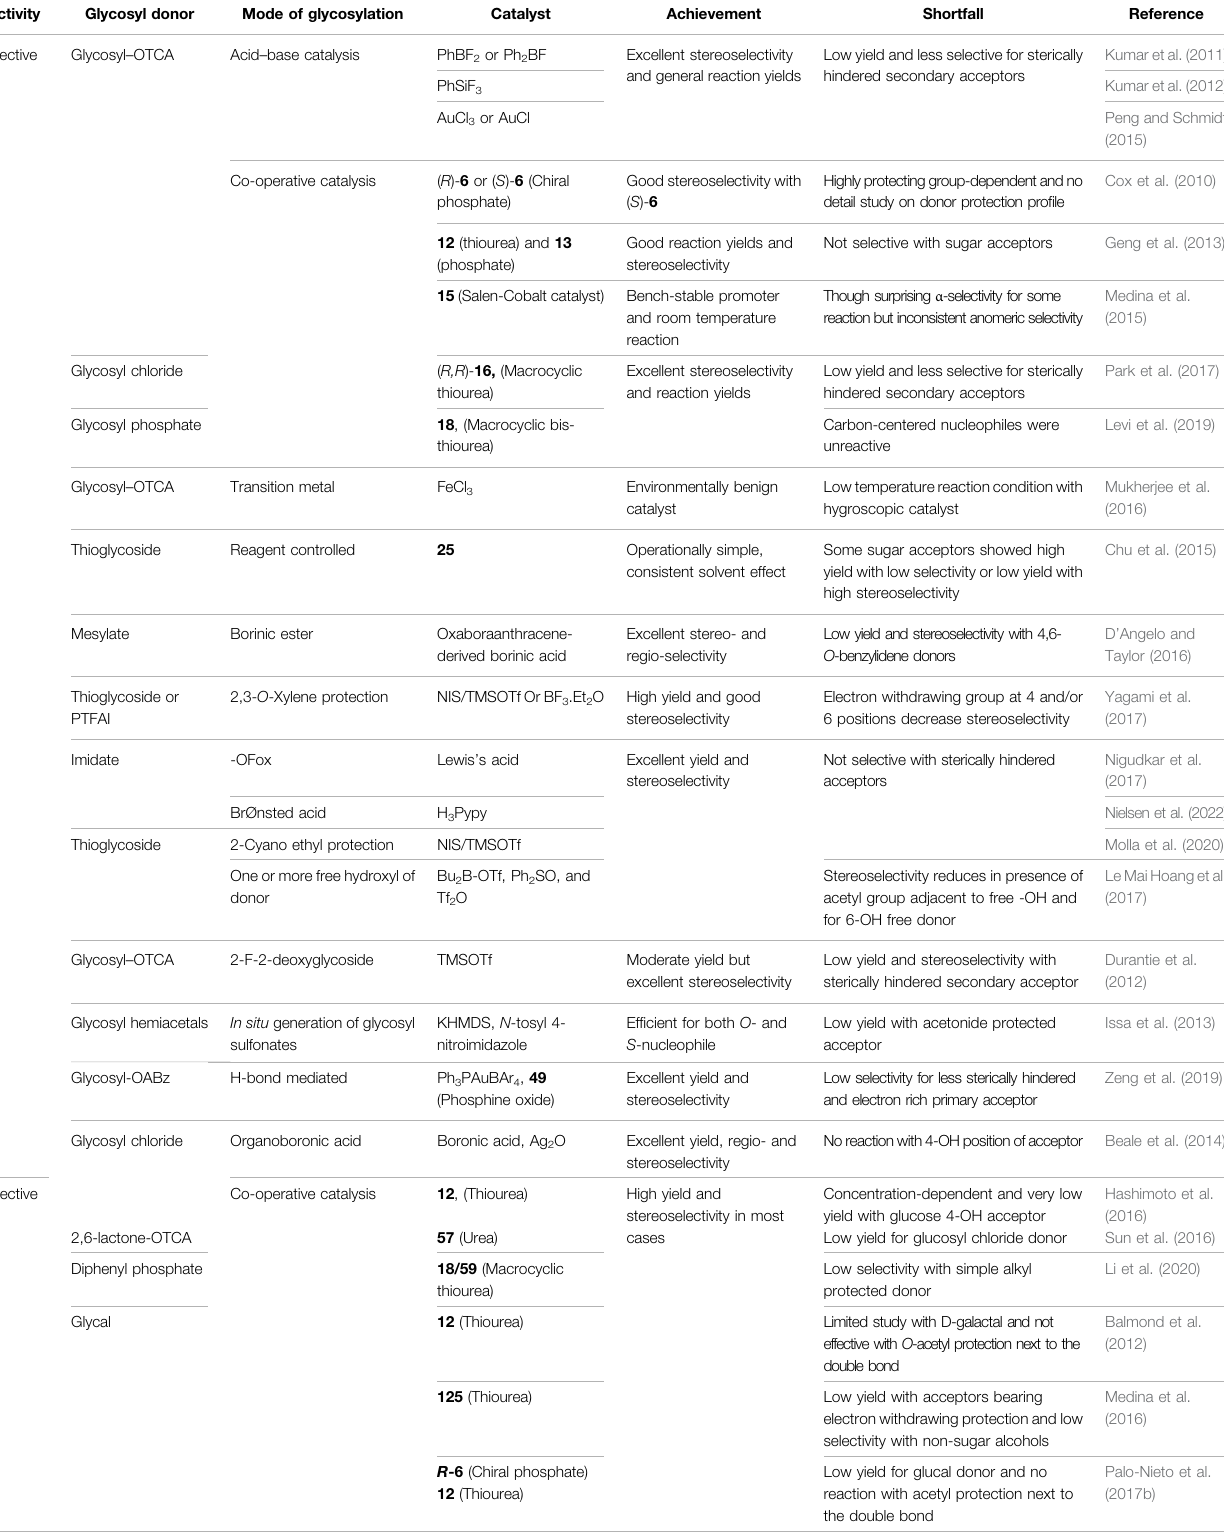
TABLE 1 | Schematic presentation of the developed methods with achievements and